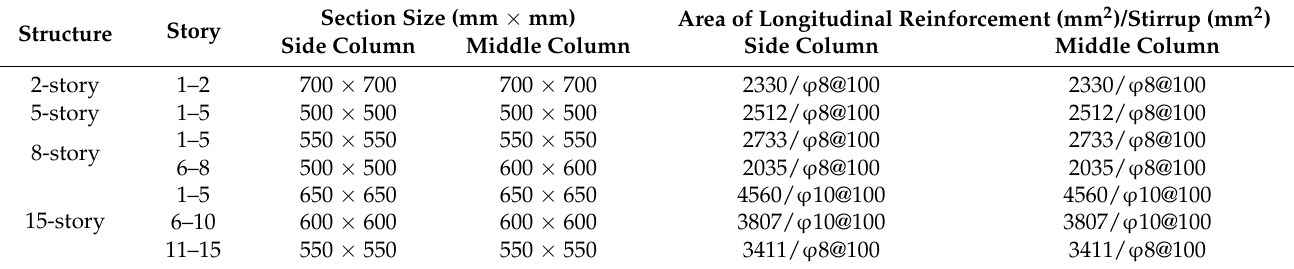
Table 4. Column section properties for four RC frame